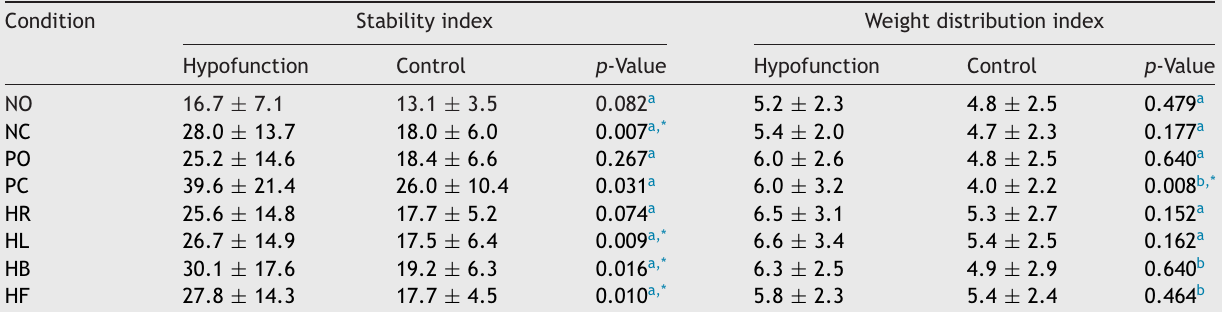
Analysis of the stability index and the weight distribution index in the eight conditions of the Tetrax Interactive Balance System (Tetrax TM ) in 32 control subjects and 25 patients with vertigo and unilateral vestibular hypofunction from the experimental group.